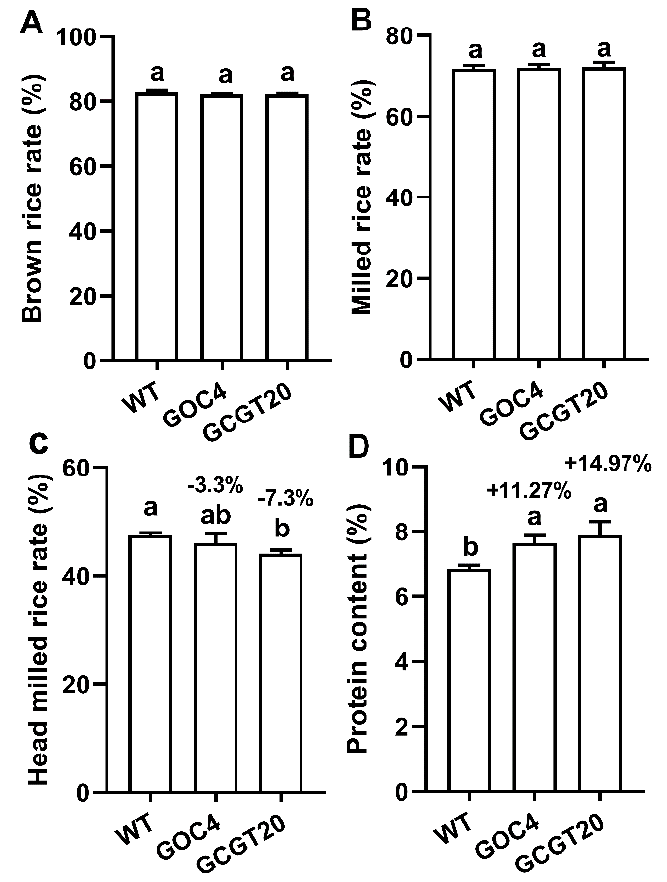
Figure 1. Milling and nutritional quality of GOC4, GCGT20, and WT rice grains. ( A ) Brown rice rate, ( B ) milled rice rate, ( C ) head rice rate, and ( D ) protein content. Data are presented as the mean ± SD according to one-way ANOVA followed by a Duncan’s test for means comparison. Different letters indicate significant differences ( n = 4, p < 0.05) .